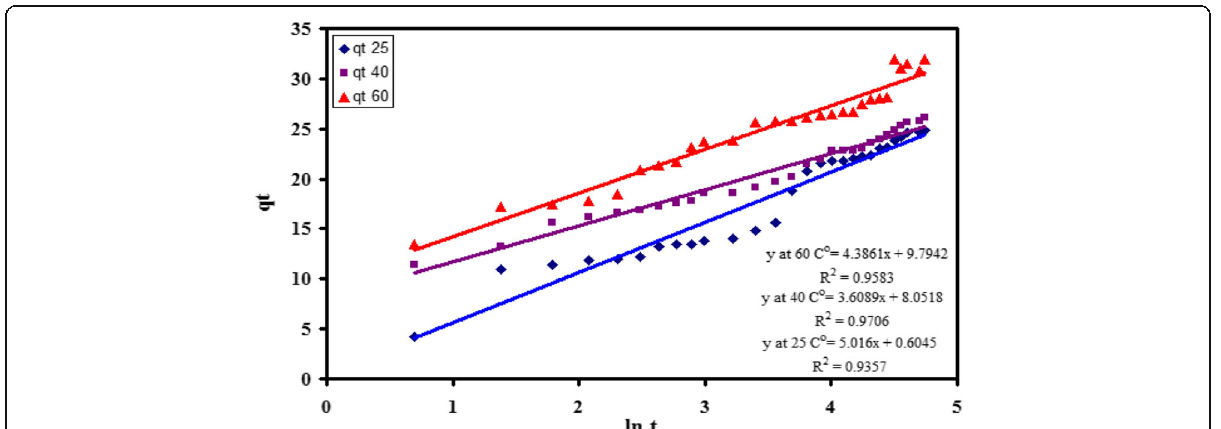
Fig. 12 Elovich equation model plot at different temperature of adsorption AO67 onto RPSF [pH = 2.5, concentration 100 mg/L, and adsorbent dose 0.2